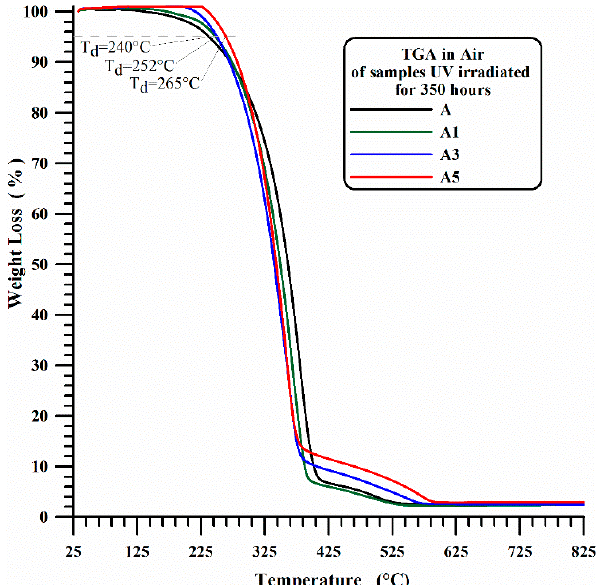
Figure 3. TGA in air of iPP (A) and iPP-MWCNT nanocomposites (A1, A3, A5) after 350 h UV irradiation.